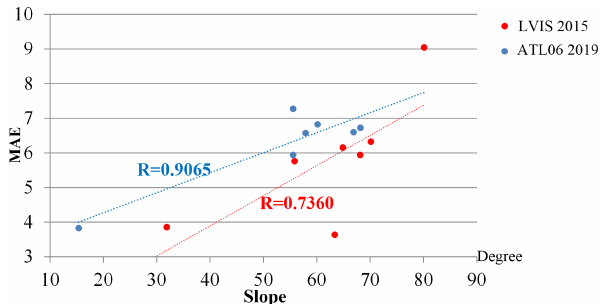
Figure 14. Linear regression between the MAE of the corrected TDM DEM using the 8m REMA mosaic as ground reference and the median slope calculated from the corrected TDM DEM at the elevation ranges as in Fig.